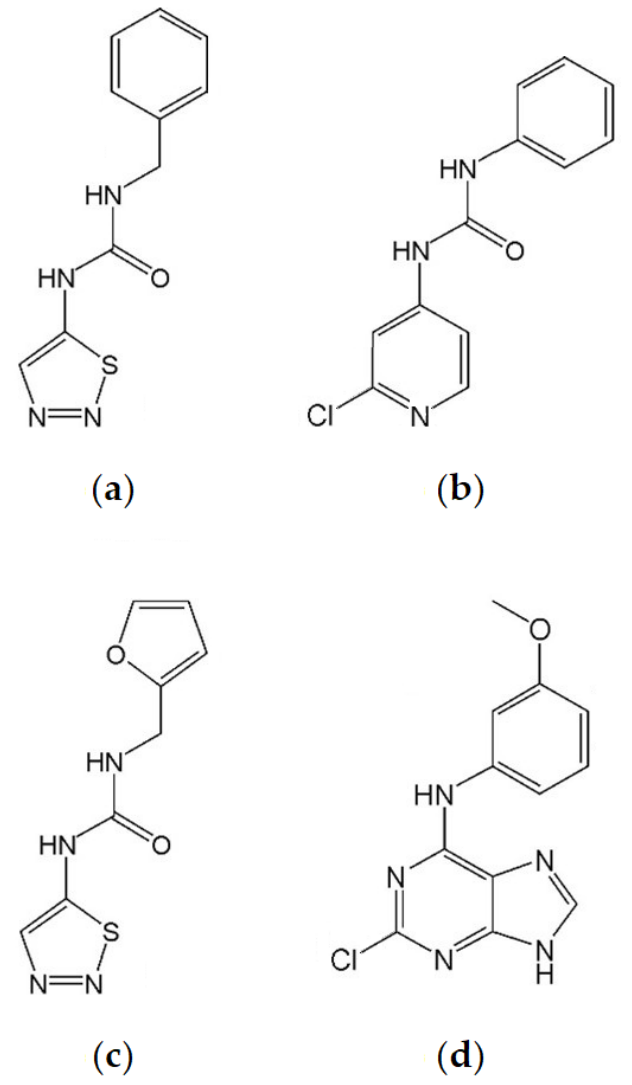
Figure 1. Structures of plant growth regulators. ( a ) Thidiazuron. ( b ) CPPU. ( c ) TD-K. ( d )